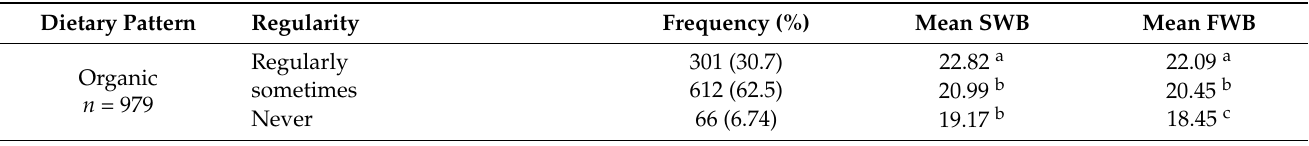
Table 3. Frequency of consumption different food category and the level of FWB and SWB. ŋ Table 2. Basic data concerning the level of SWB and FWB.